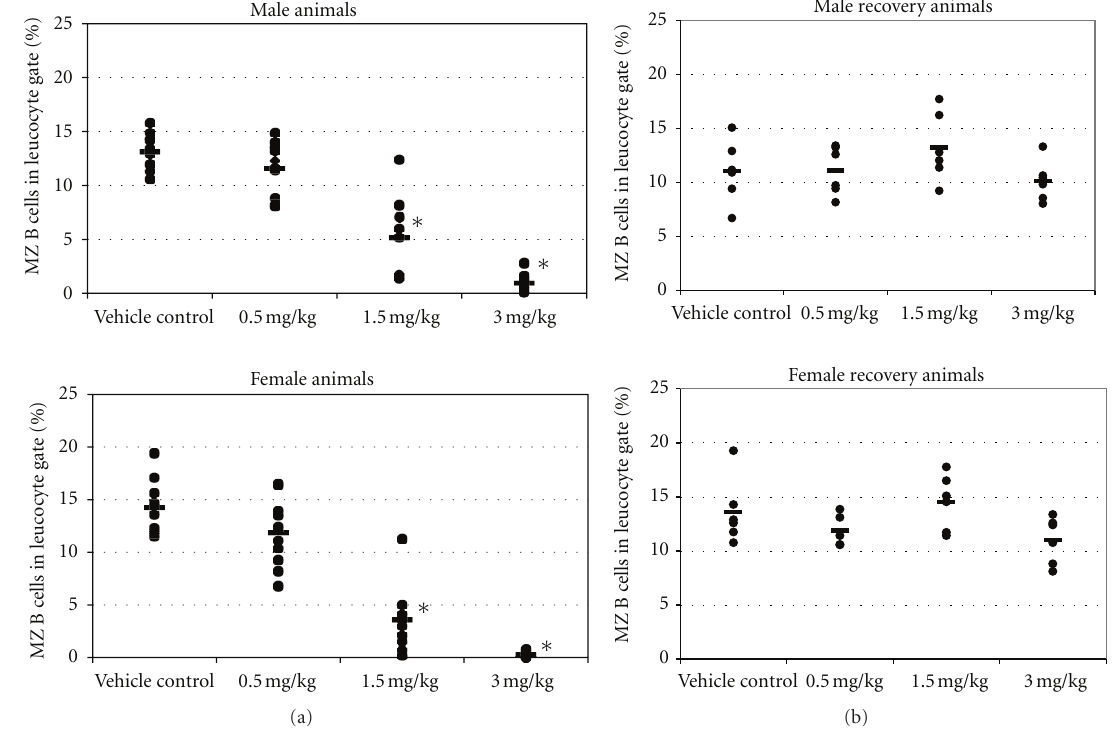
Figure 1: (a) Marginal zone B cells in male and female rats dosed for 13 weeks with RO4929097. Spleen cell suspensions were analyzed by flow cytometry (FACS) using fluorescently labeled antibodies. For each rat the percentage of MZ B cells ( = IgM high /CD90 low / neg /HIS57 + ) in the leukocyte gate is shown. Dots represent individual rats. - = average per group. ∗ = statistically significant di ff erence to vehicle control ( P < 0 . 05). n = 10rats/sex/group. (b) Splenic MZ B cells in male and female rats dosed for 13 weeks with RO4929097 followed by a recovery phase of 6 weeks. Dots represent individual rats. - = average per group. n = 6rats/sex/group.